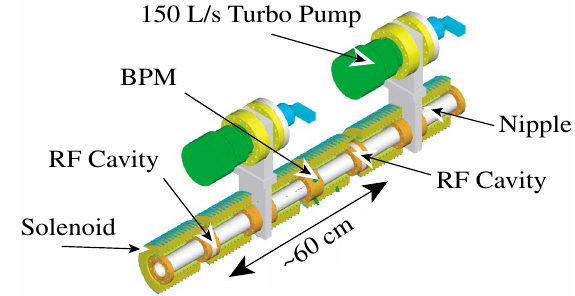
FIG. 5. (Color) Photograph of the RTA experimental hall.